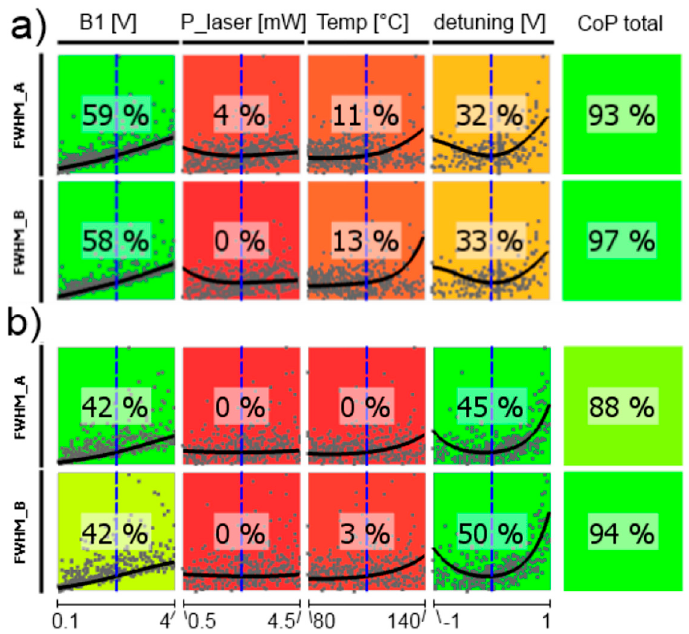
Figure 13. CoP matrix of the resonance widths. ( a ) high-pressure magnetometer; ( b ) medium-pressure magnetometer. Approximation technique: ( a ) isotropic kriging; ( b ) linear regression.